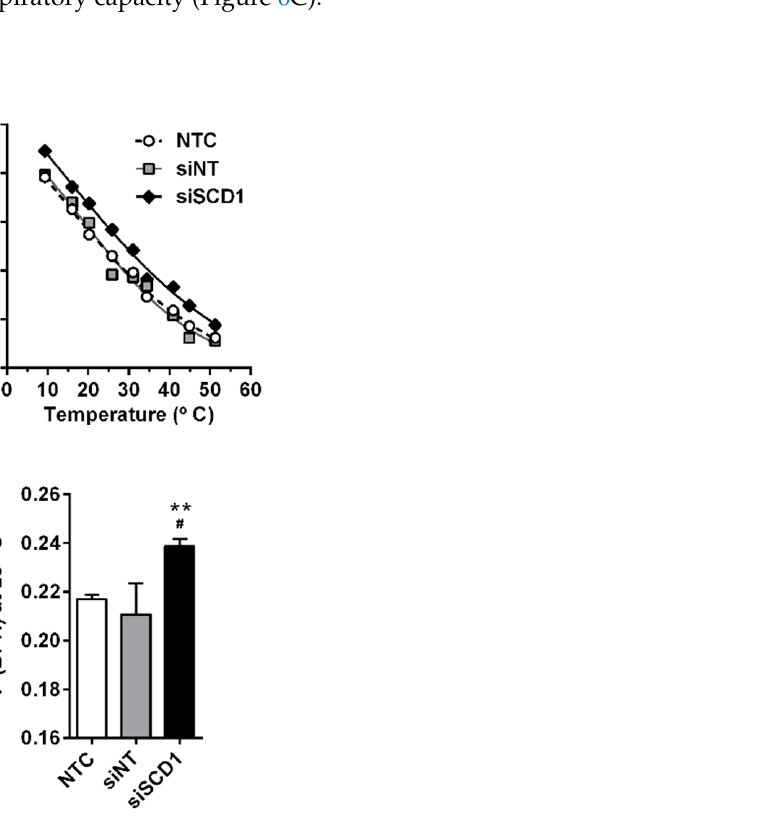
Figure 5. Fluorescence polarization of DPH incorporated in liposomal membranes prepared from the lipid extracts of U87 cells. Cells grown in medium containing 2% FBS were transfected with an siRNA against SCD1 (siSCD1) or a non-targeting siRNA sequence (siNT) complexed with Lipofectamine RNAiMAX. Sixty-eight hours after transfection, lipids were extracted and used to prepare liposomes, to which a small aliquot of a 2 mM DPH solution in tetrahydrofuran was added under vortex. Fluorescence polarization (P) of DPH was determined in the three liposome preparations (with respect to non-treated cells, NTC, and cells transfected with siSCD1 or siNT), over the temperature range from 10 to 50 ◦ C ( A ). DPH fluorescence polarization values at 25 ◦ C ( B ) were taken from thermograms similar to the typical thermogram shown in panel A, for comparison in the three liposome samples ( n = 3; one-way ANOVA followed by Tukey’s test; # p < 0.05, vs. NTC; ** p < 0.01 vs.